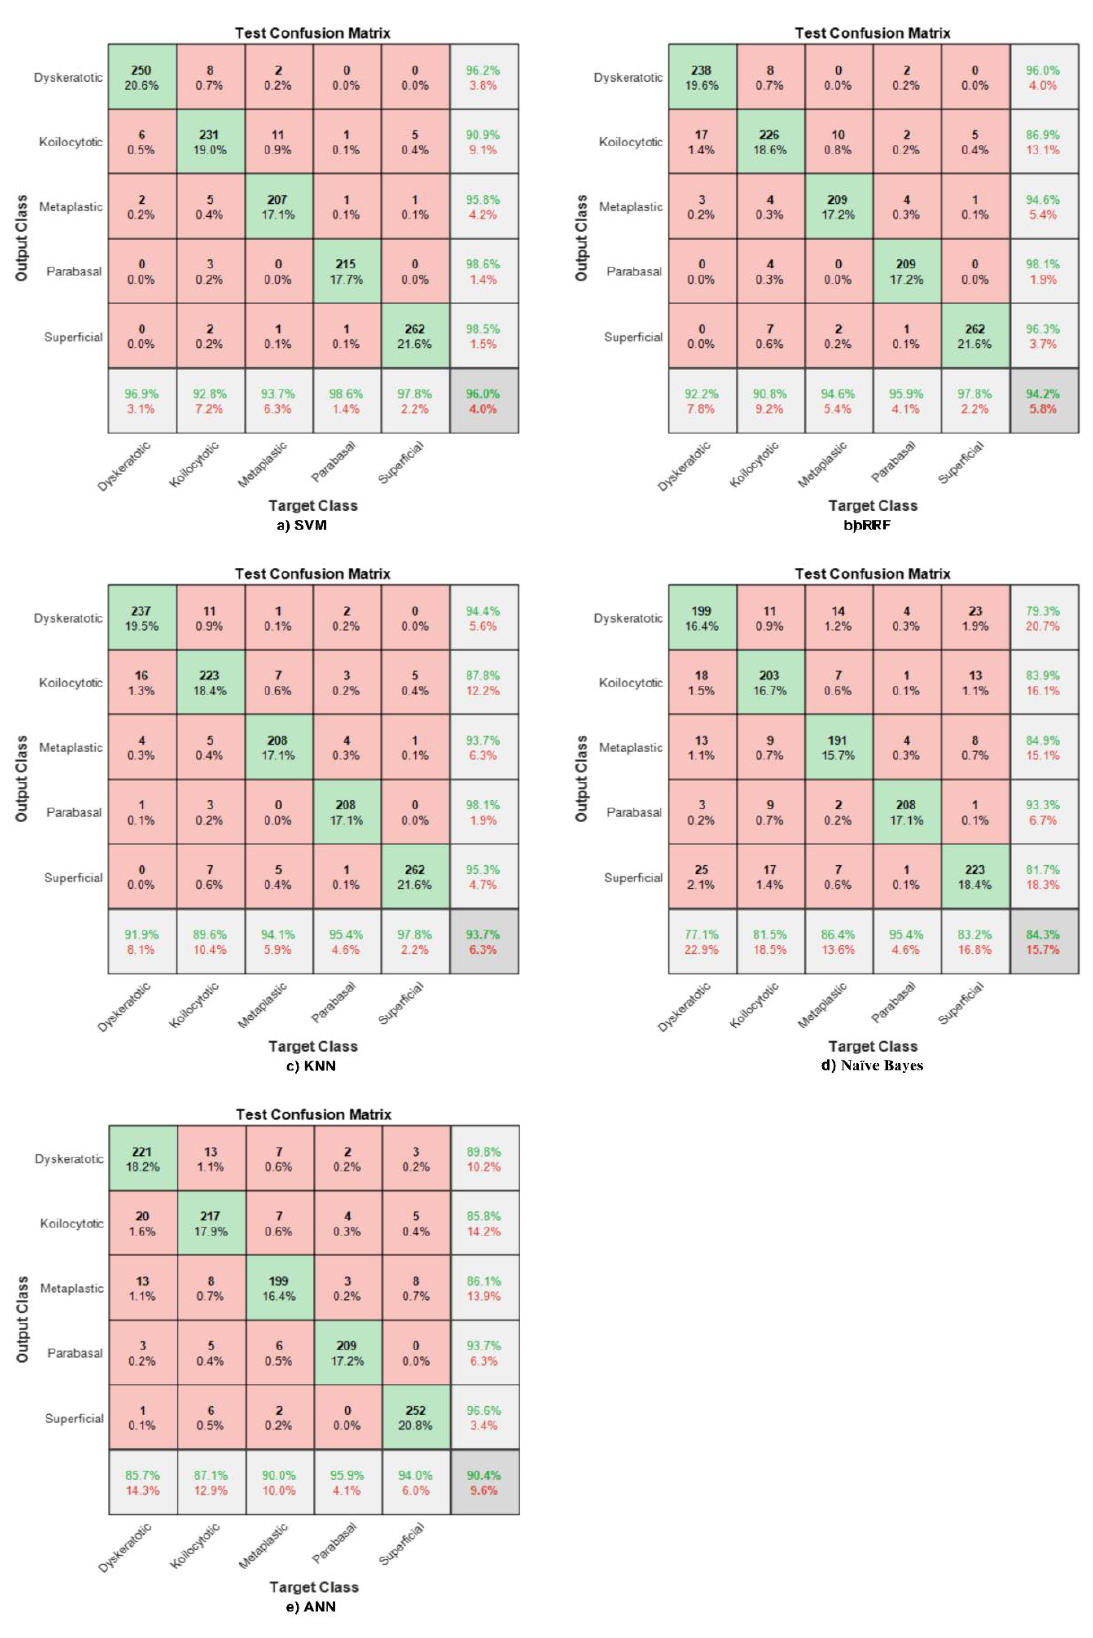
Figure 7. Confusion matrix with respect to Cervical Net features for different ML classifiers. ( a ) SVM, ( b ) RF, ( c ) KNN, ( d ) Naïve Bays, ( e ) ANN. ( b ) RF, ( c ) KNN, ( d ) Naïve Bays, ( e )